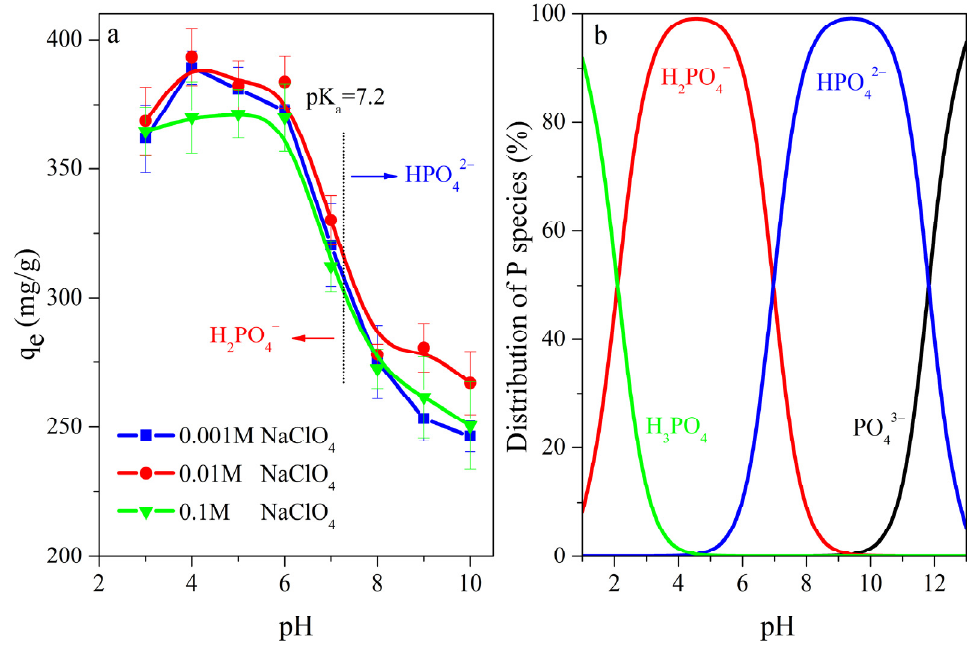
Figure 2. ( a ) Effect of initial pH on adsorption of phosphate on MTPG; ( b ) distribution of phosphorus species in liquids (C 0 = 1000 mg/L, MTPG = 0.4 g/L, t = 12 h, T = 298 K).